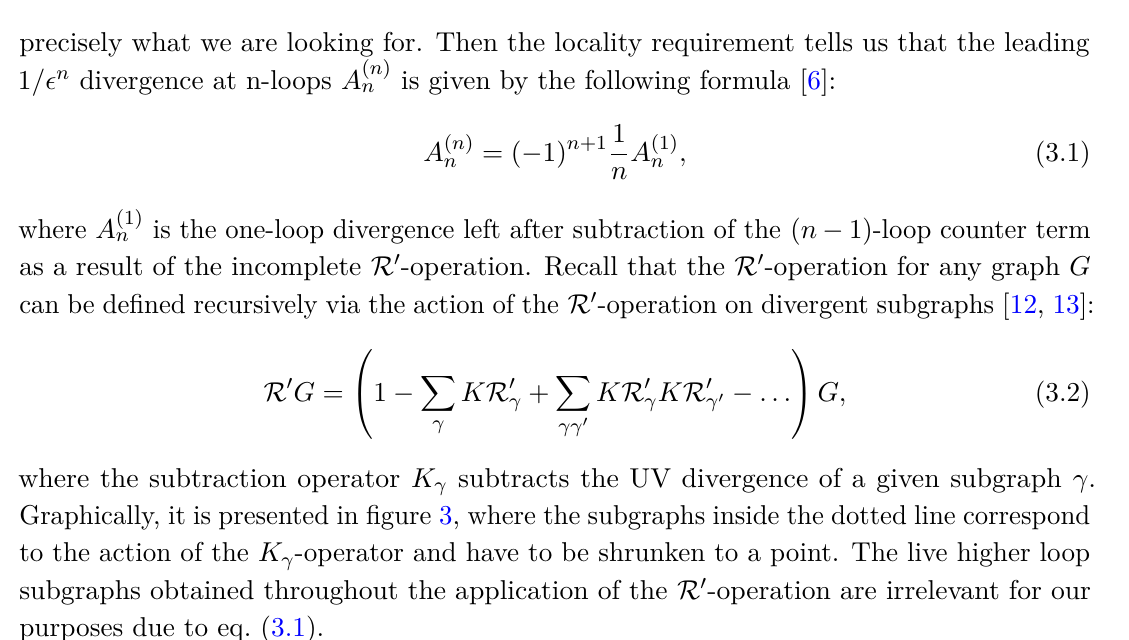
Figure 4 . R 0 -operation for the two-loop